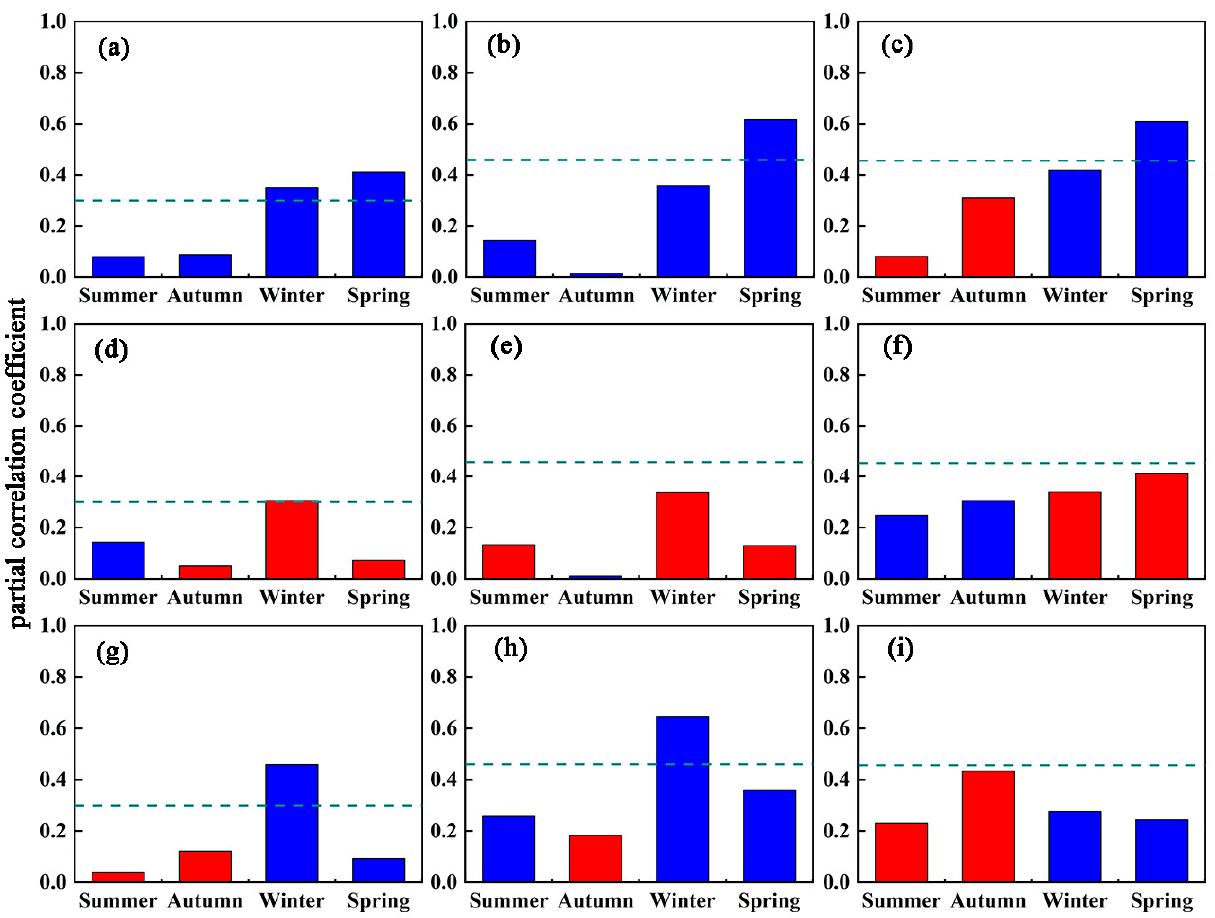
Figure 5. The response of deciduous needleleaf forest starting date of the growing season (DNF SOS) to changes in Tmax ( a – c ), Tmin ( d – f ), and precipitation ( g – i ) for the entire study period of 1982–2013 (graphs ( a , d , g ) at left), earlier rapid warming period to 1998 (graphs ( b , e , h ) in the middle), and short-term slowdown from 1998 (graphs ( c , f , i ) at right). Dashed lines indicate a significance level of 0.10; blue bars indicate negative correlations; red indicates positive correlations.